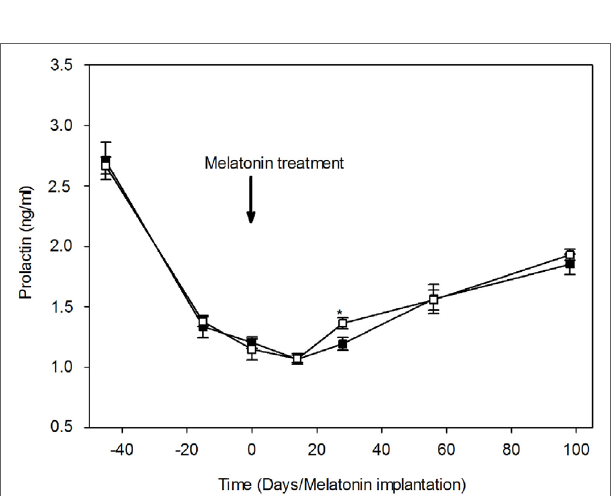
FigUre 4 | Variations of plasma prolactin concentrations (mean ± SEM) in camel females of the melatonin-treated group ( ◾ ) and control group ( ◽ ). Time is expressed as days relative to the melatonin implants insertion: before and after day 0. At day 28, prolactin concentration was significantly (* P < 0.05) lower in the melatonin-treated group compared to the control